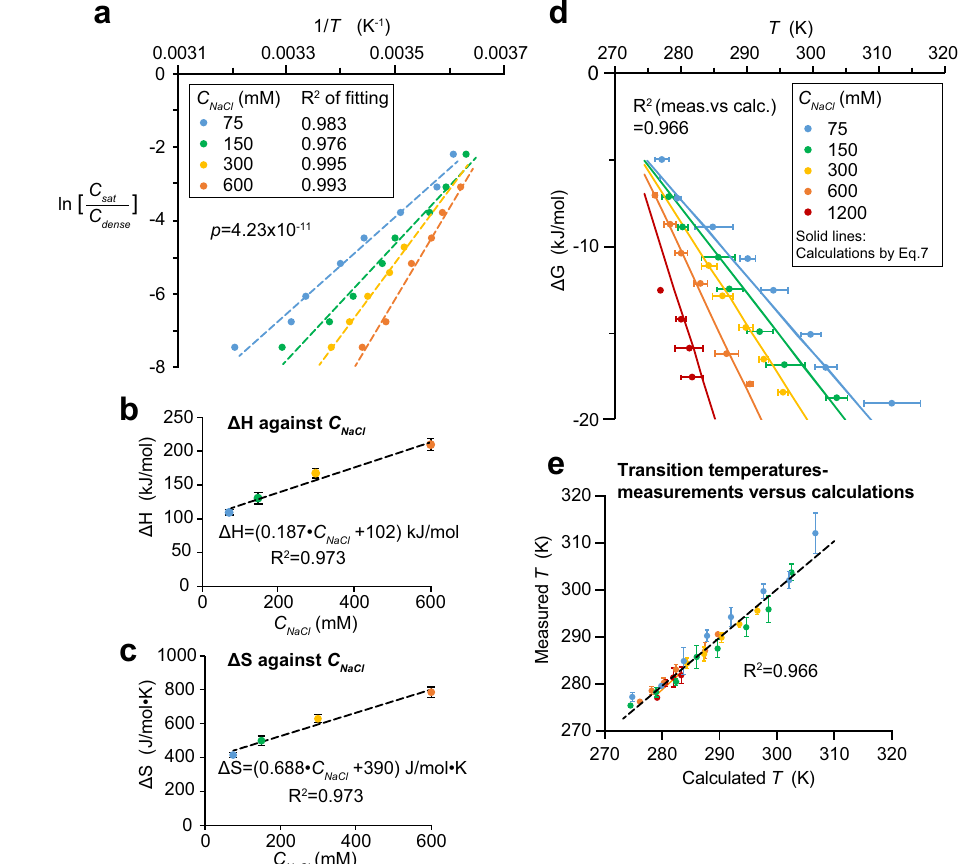
Interestingly, both Δ H and Δ S scale linearly with C NaCl . d Dataset from Fig. 3d is converted to Δ G against T (in Kelvin) byEq. 2 and a datasetmeasured atextra high [NaCl] (1200mM) is added. Mean values of three replicates with independent samples are shown with S.D. as the error bars. All these data can be captured by a plot of Eq. 7 (solid lines), which is derived from a thermodynamic model and observations in ( b , c ). R-squared value here shows the degree of correlation between the dataset and calculations from Eq. 7. e Values of T at different condi- tions ( C sat and C NaCl ; same colouring as in d ) were calculated by Eq. 8 and are plotted against values obtained in experiments. R-squared value shows the degree of correlation between the calculations and